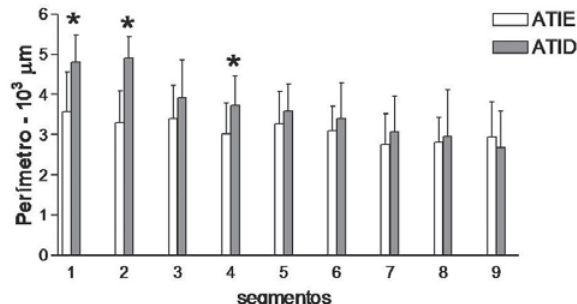
Fig. 3 – Comparação entre o perímetro interno da artéria torácica interna esquerda (ATIE) e direita (ATID). O perímetro interno de ambas as ATIs diminui ao longo do percurso. Os segmentos proximais da ATID mostram valores de perímetro que são significativamente maiores que os da ATIE (* diferença significativa entre ATIE e ATID,